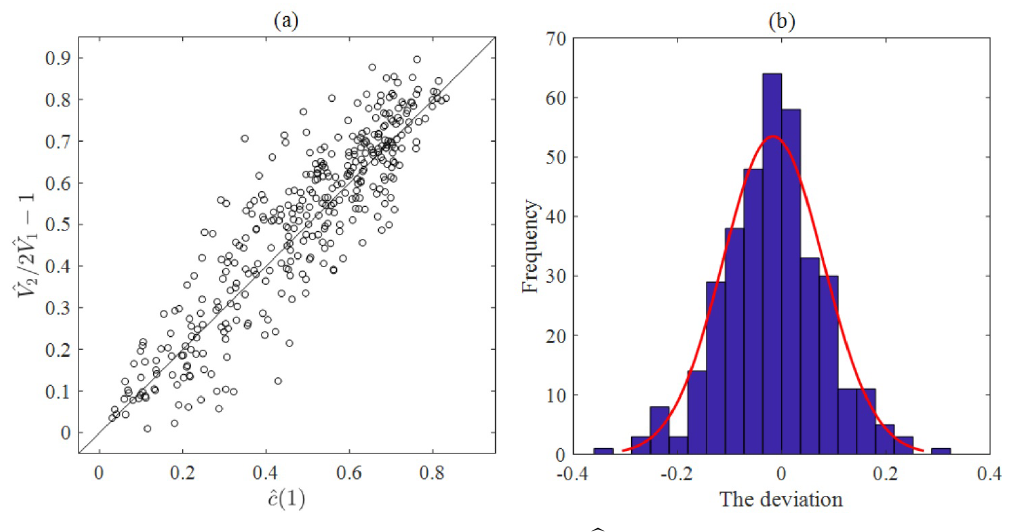
− 1 (vertical axis) of the autocorrelation lag-1 of hourly 2 b V 1